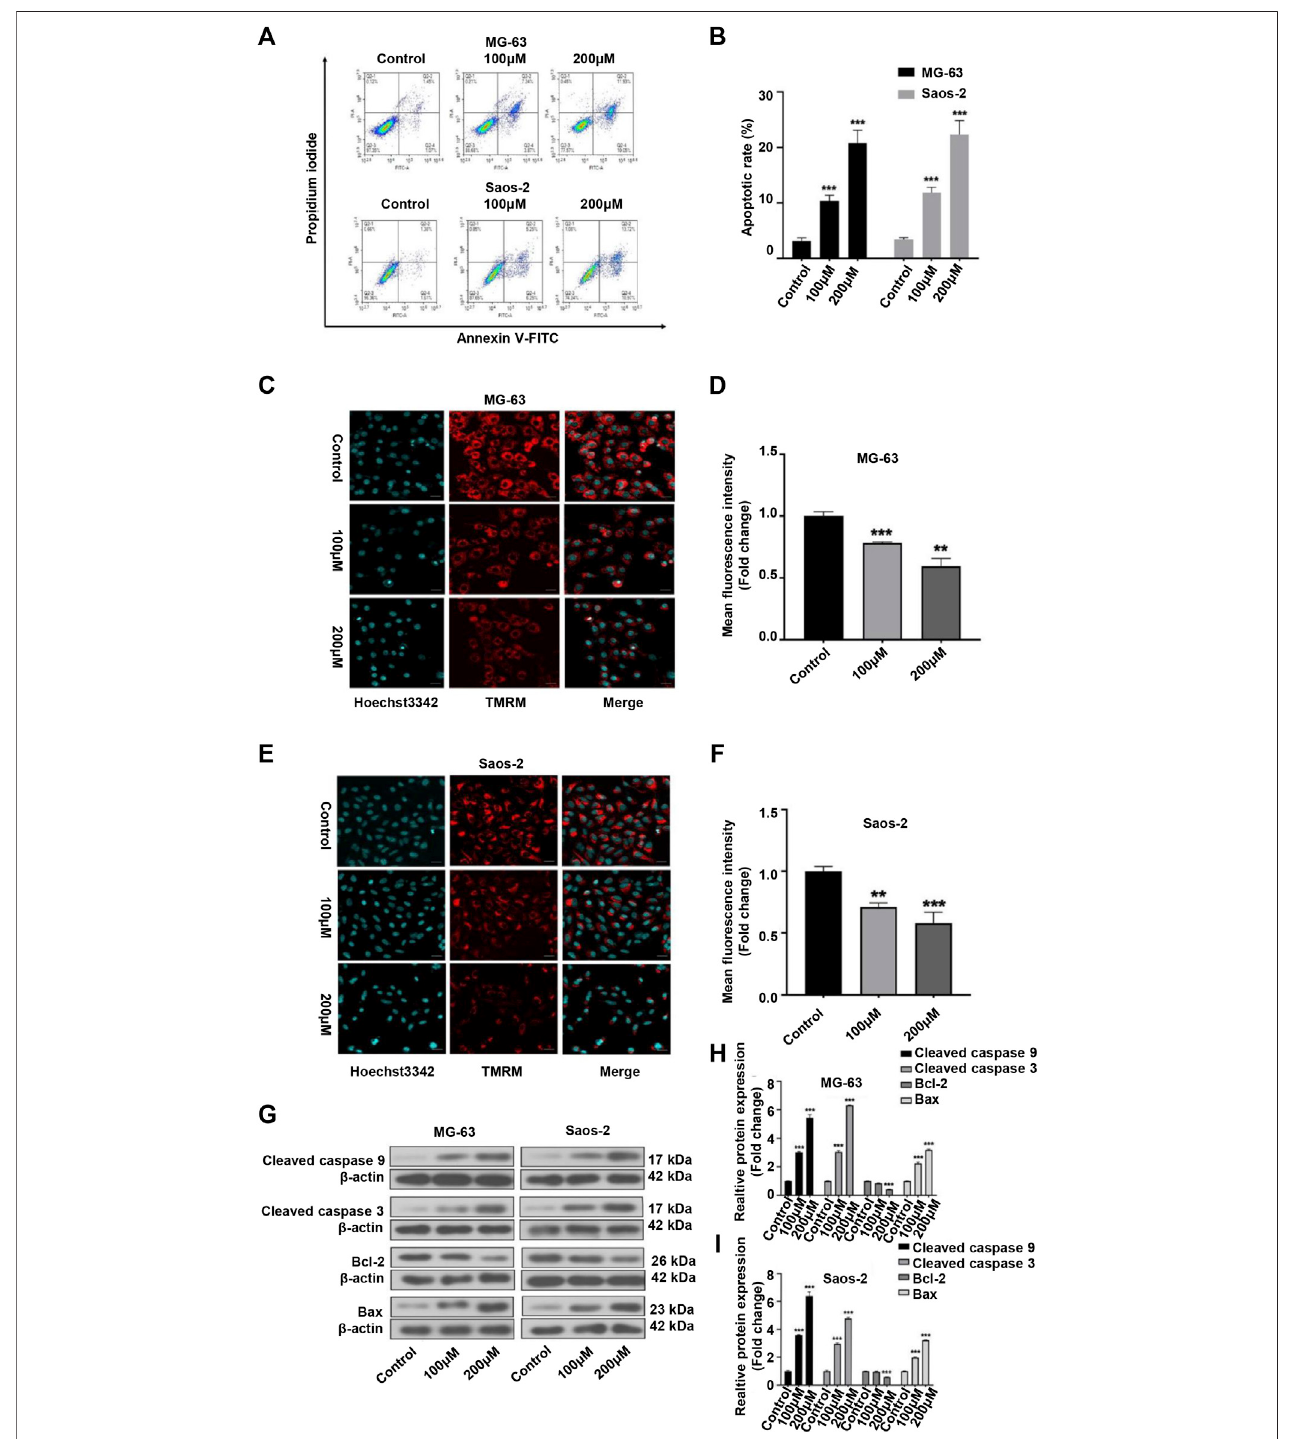
FIGURE3| Peiminineinducedapoptosisinosteosarcoma(OS)cells. (A,B) OScellswerestainedwithAnnexinV-FITC/PIandthepercentageofapoptoticcellswas determined by fl ow cytometry. (C,E) Images of tetramethylrhodamine methyl ester (TMRM) staining showing that peiminine treatment led to the depolarization of the mitochondrial membrane.Scalebar (cid:2) 20 μ m. (D,F) QuantitativeanalysisofthemitochondrialmembranepotentialinOScells. (G) Western blotwasused toexamine the expression ofcleaved caspase-9, cleaved caspase-3, Bcl-2, and BaxinOScells. β -actinwasused ascontrol. (H,I) Quantitative analysisofthelevels ofapoptosis- related proteins ( n (cid:2) 3). ** p < 0.01, *** p < 0.001.